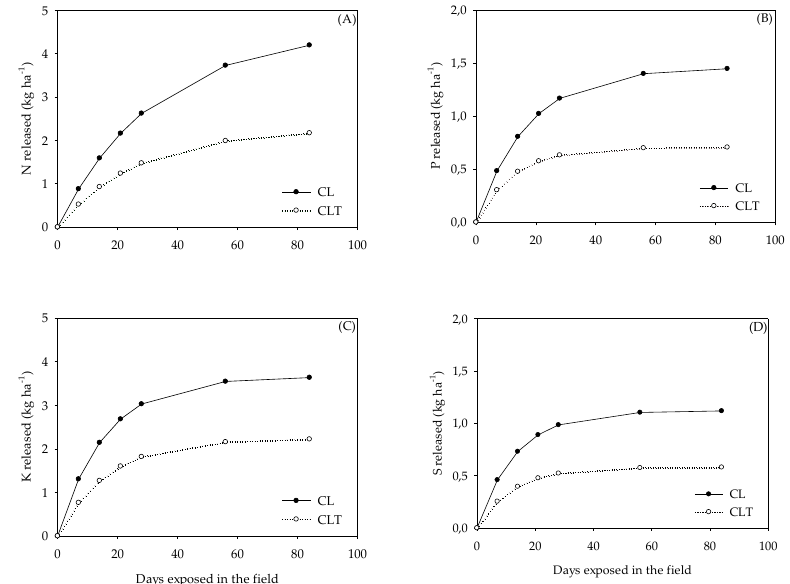
Figure 7. Nitrogen (N), phosphorus (P), potassium (K) and sulphur (S) released (kg ha − 1 ) from the cattle dung residue, during exposure into the pasture (i.e., Lolium multiflorum + Avena strigosa ; A , B , C and D ) as affected by the systems (CL, crop–livestock and CLT, crop–livestock–tree).